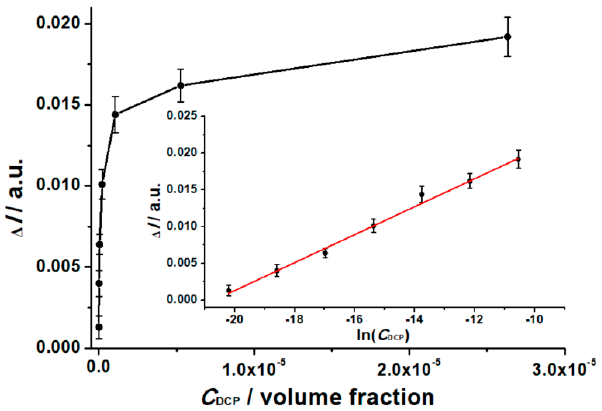
Figure 5. Relationship between the changes of output light intensity of CV-SiO 2 gel film coated the PIE OWG sensor and the concentration of the DCP vapor. Insert graph is the calibration curve.